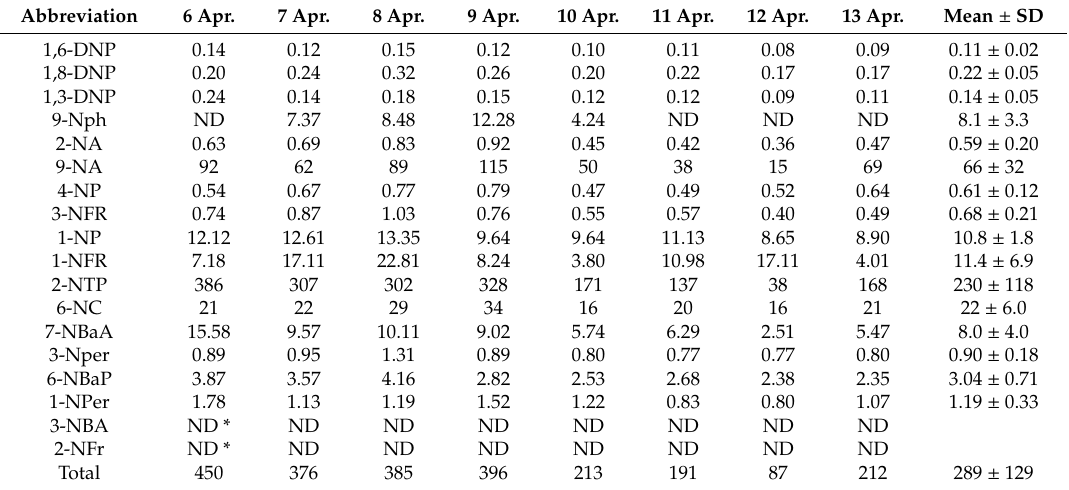
Table 5. Daily and weekly mean concentrations of nitrated polycyclic aromatic hydrocarbons (NPAHs) in atmospheric PM 10 of Lijiang (pg / m 3